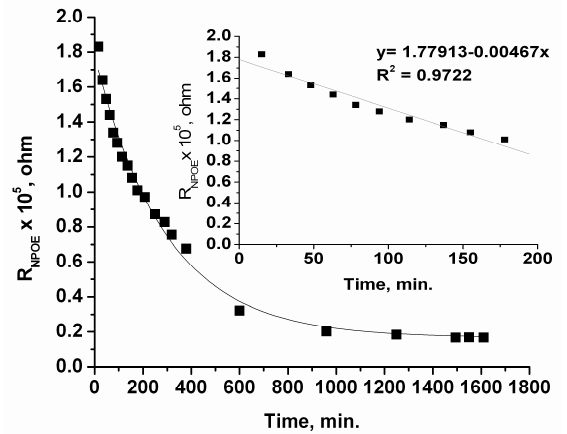
Figure 15. Dependence of membrane electric resistance on the immersion time in MES buffer solution. The detail presents the decrease of the membrane resistance with the time in the first 200 min of immersion.